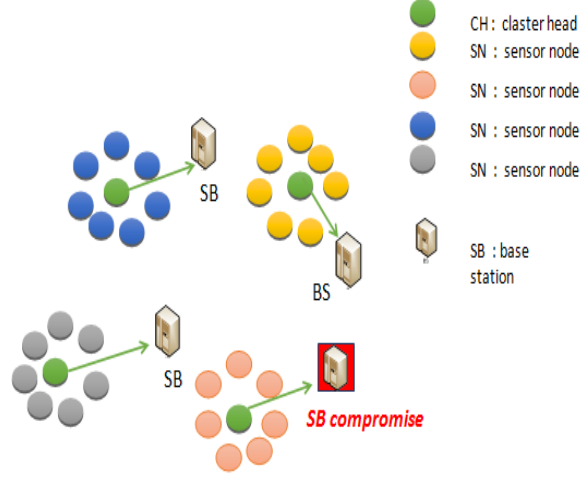
Figure 5 . Scenario with multiple BSs, and one